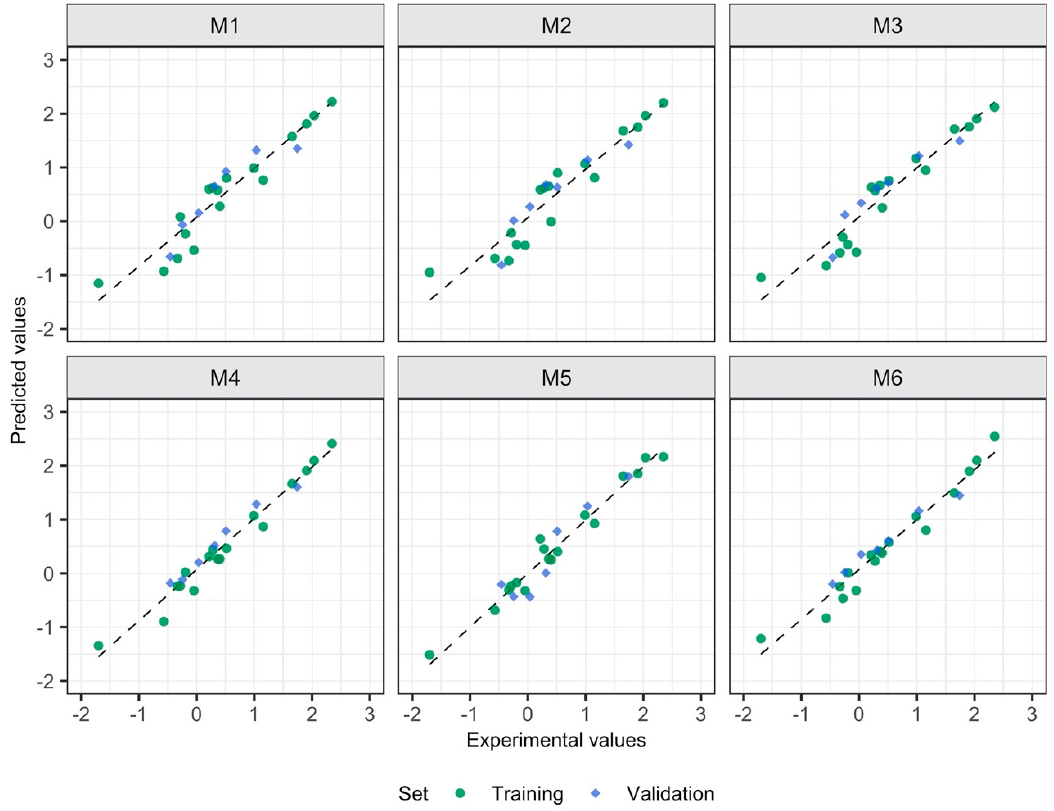
Figure 3. Experimental vs. predicted toxicity towards E. coli (log EC 50 , (mM)).